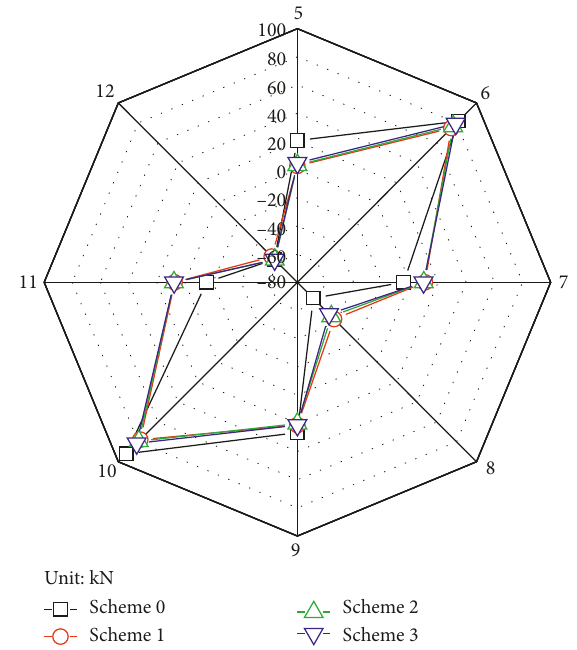
Figure 18: Additional normal forces of the tunnel structure after the foundation pit excavation.